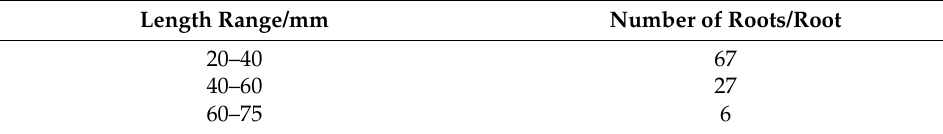
Table 3. Length distribution of waste hemp